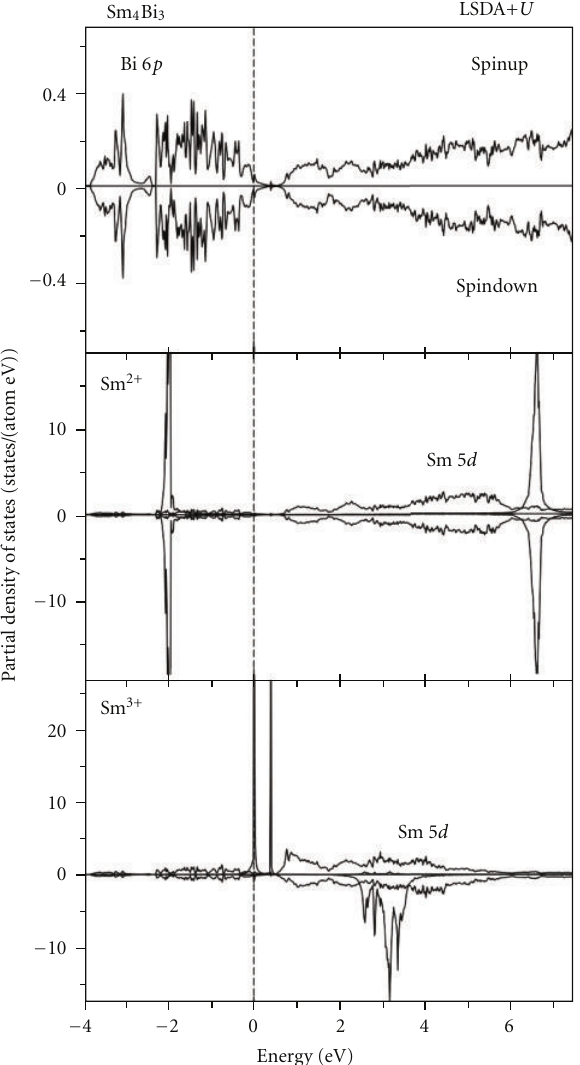
Figure 81: The partial density of states (in states/(atom eV)) of Sm 4 Bi 3 calculated in LSDA+ U approximation ( U = 7 . 0 eV) for the low-temperature R 3 c phase